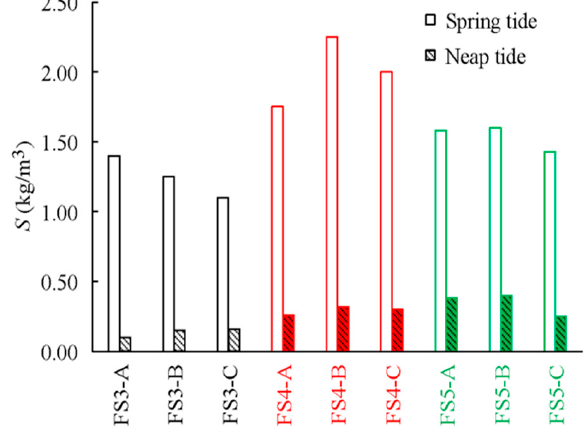
Figure 4. S distributions of lines A, B and C at each FS during the wet season (2nd half of June 2015).